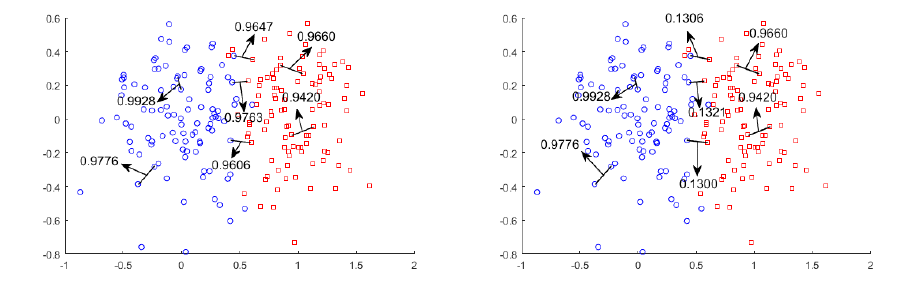
Figure 1. Comparisons between two types of similarities between samples, shown as ( a ) and ( b ). The clustering-adjusted similarity clearly tunes down the Euclidean-based similarity between two instances from different